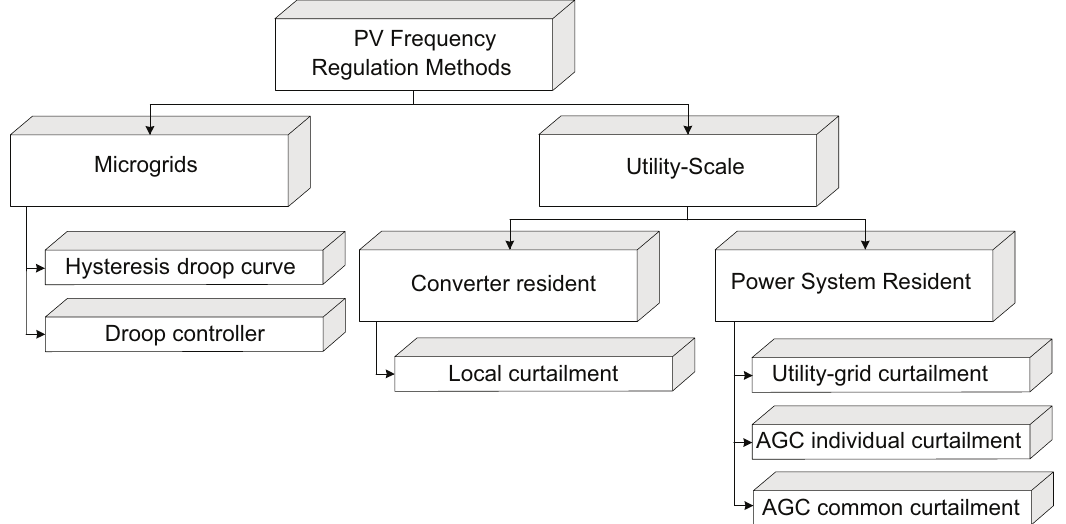
Figure 1. Frequency regulation (FR) classification methods for photovoltaic (PV) applications. AGC: automatic gain